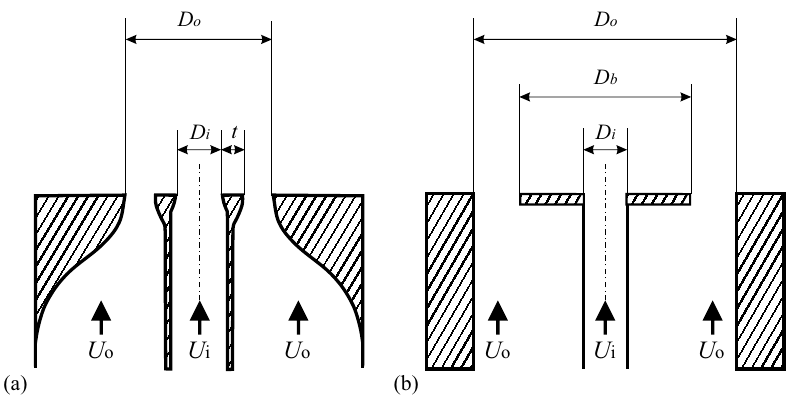
Figure 5. Schematic layout of different coaxial jet nozzle designs. ( a ) aerodynamically shaped outer jet nozzle [35], and ( b ) blockage disk installed at the exit plane